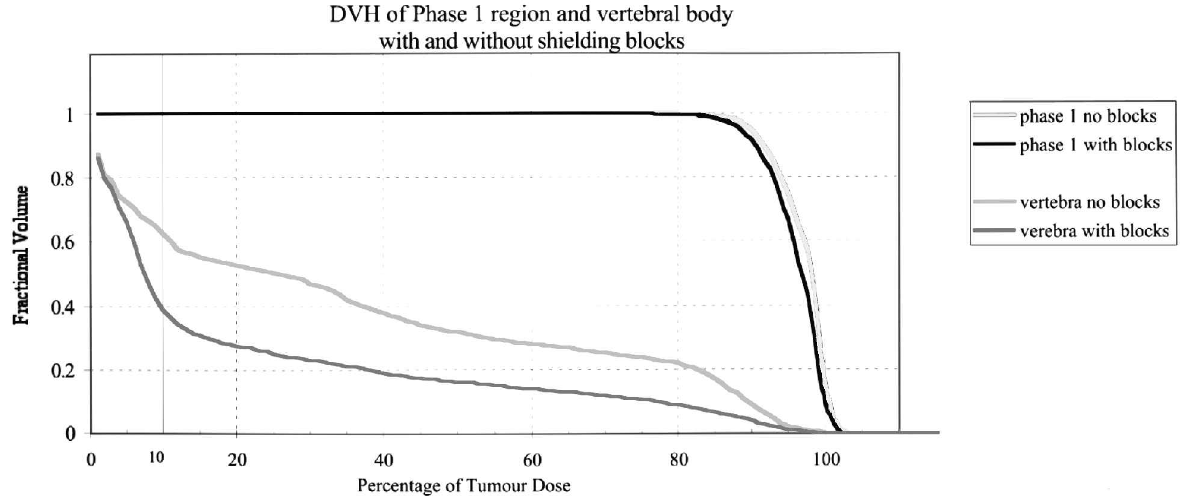
Figure 3. DVH of phase 1 region and vertebral bodies with and without shielding